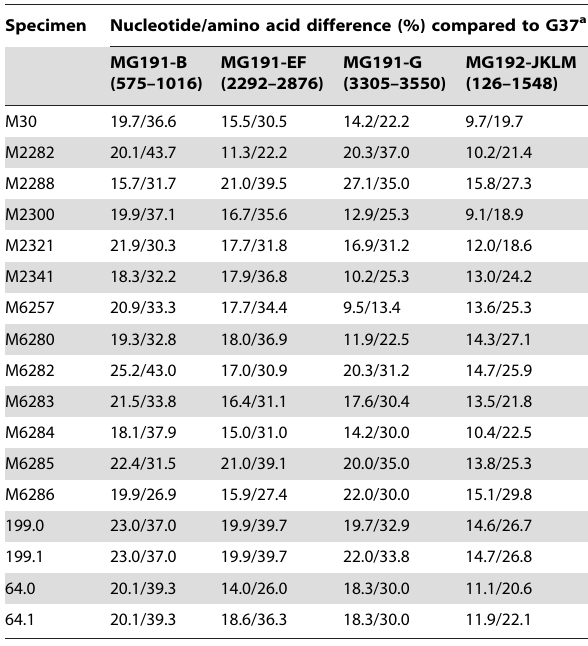
Table 2. Sequence variation in the MG191 and MG192 repeat